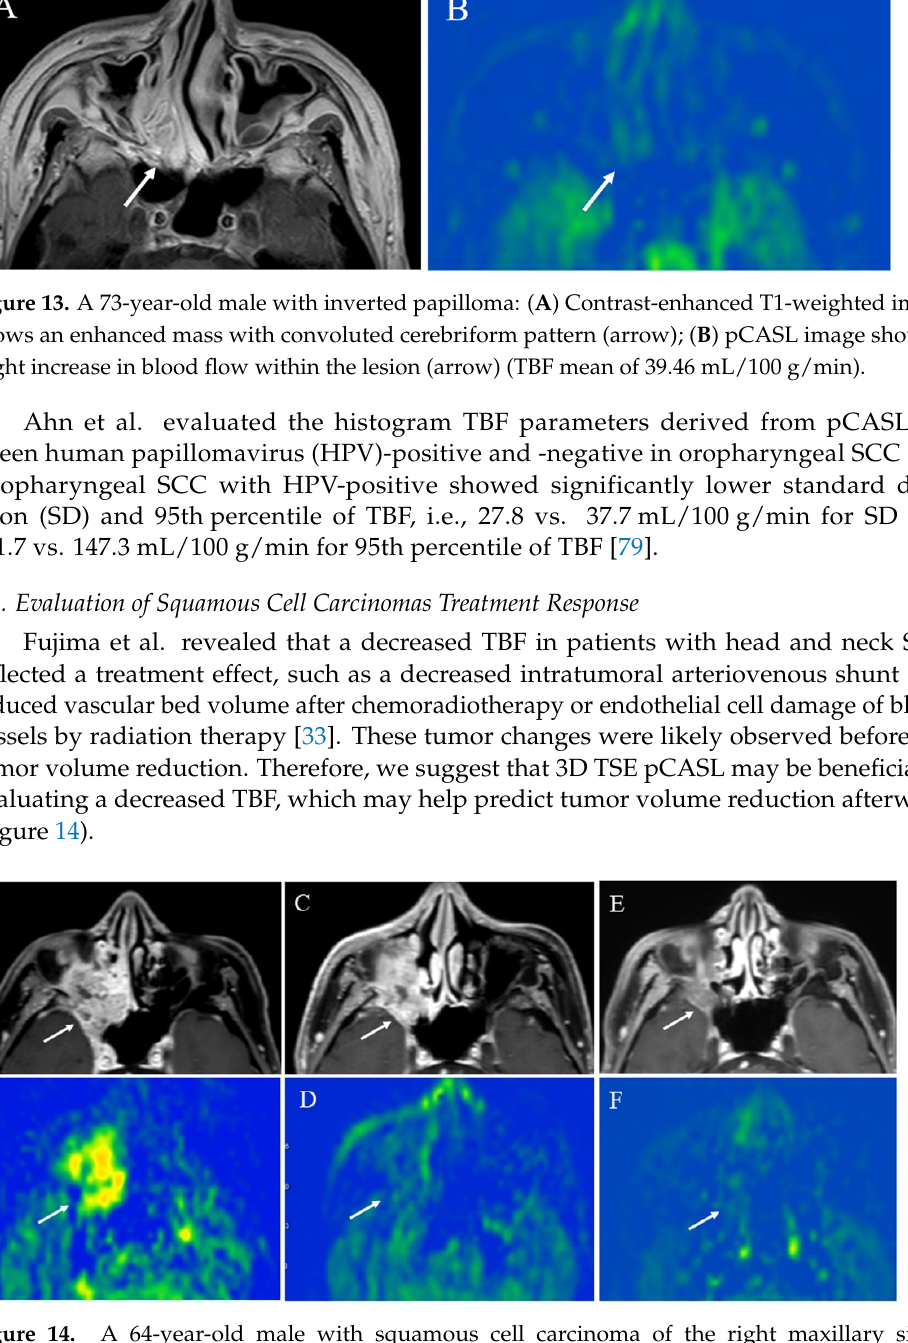
Figure 12. A 87-year-old male with squamous cell carcinoma in the right nasal cavity: ( A ) Contrast- enhanced T1-weighted image shows an enhanced mass (arrow); ( B ) pCASL image shows high blood flow within the lesion (arrow) (TBF mean of 70.17 mL/100 g/min) (arrow).